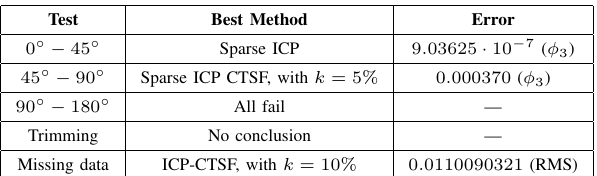
TABLE VI: Conclusions of the point cloud registration exper-